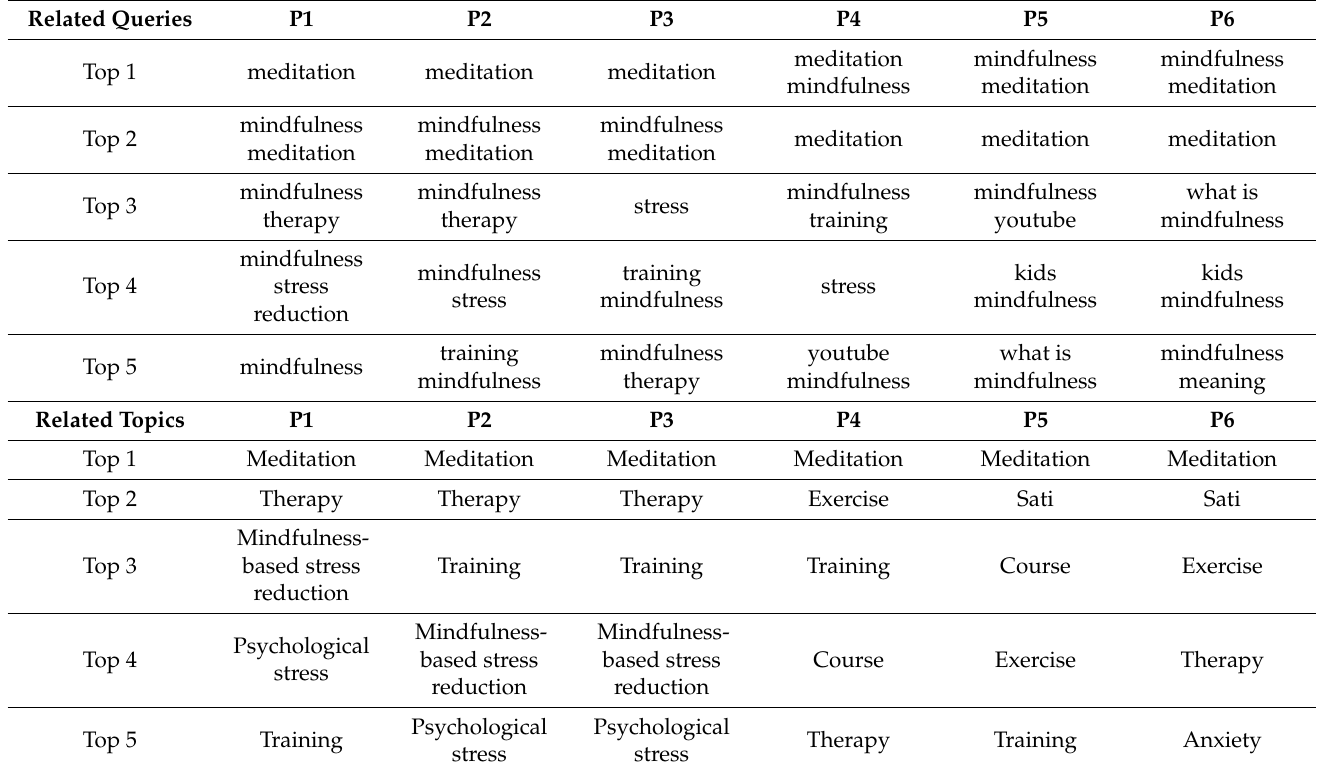
Table 2. Top queries and topics related to the search term ‘Mindfulness’ over